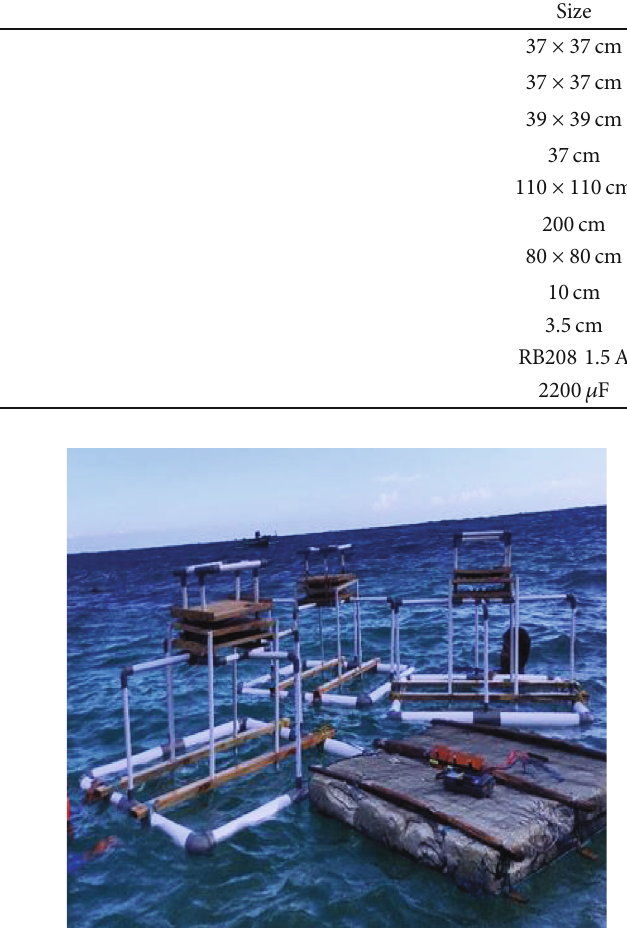
Figure 3: Testing the Cov-TOTal prototype